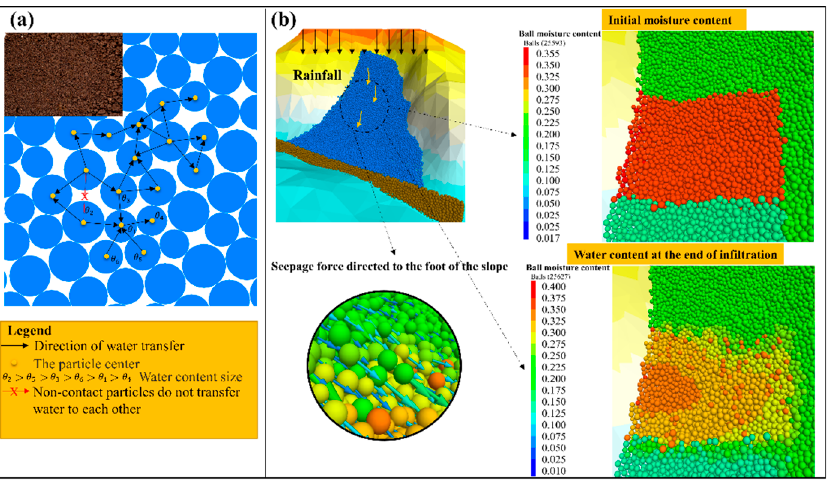
Figure 6. Water diffusion mechanism and seepage force direction. ( a ) is the water flow direction in the numerical model; ( b ) is the direction of seepage force and the distribution of water content of slope infiltration.